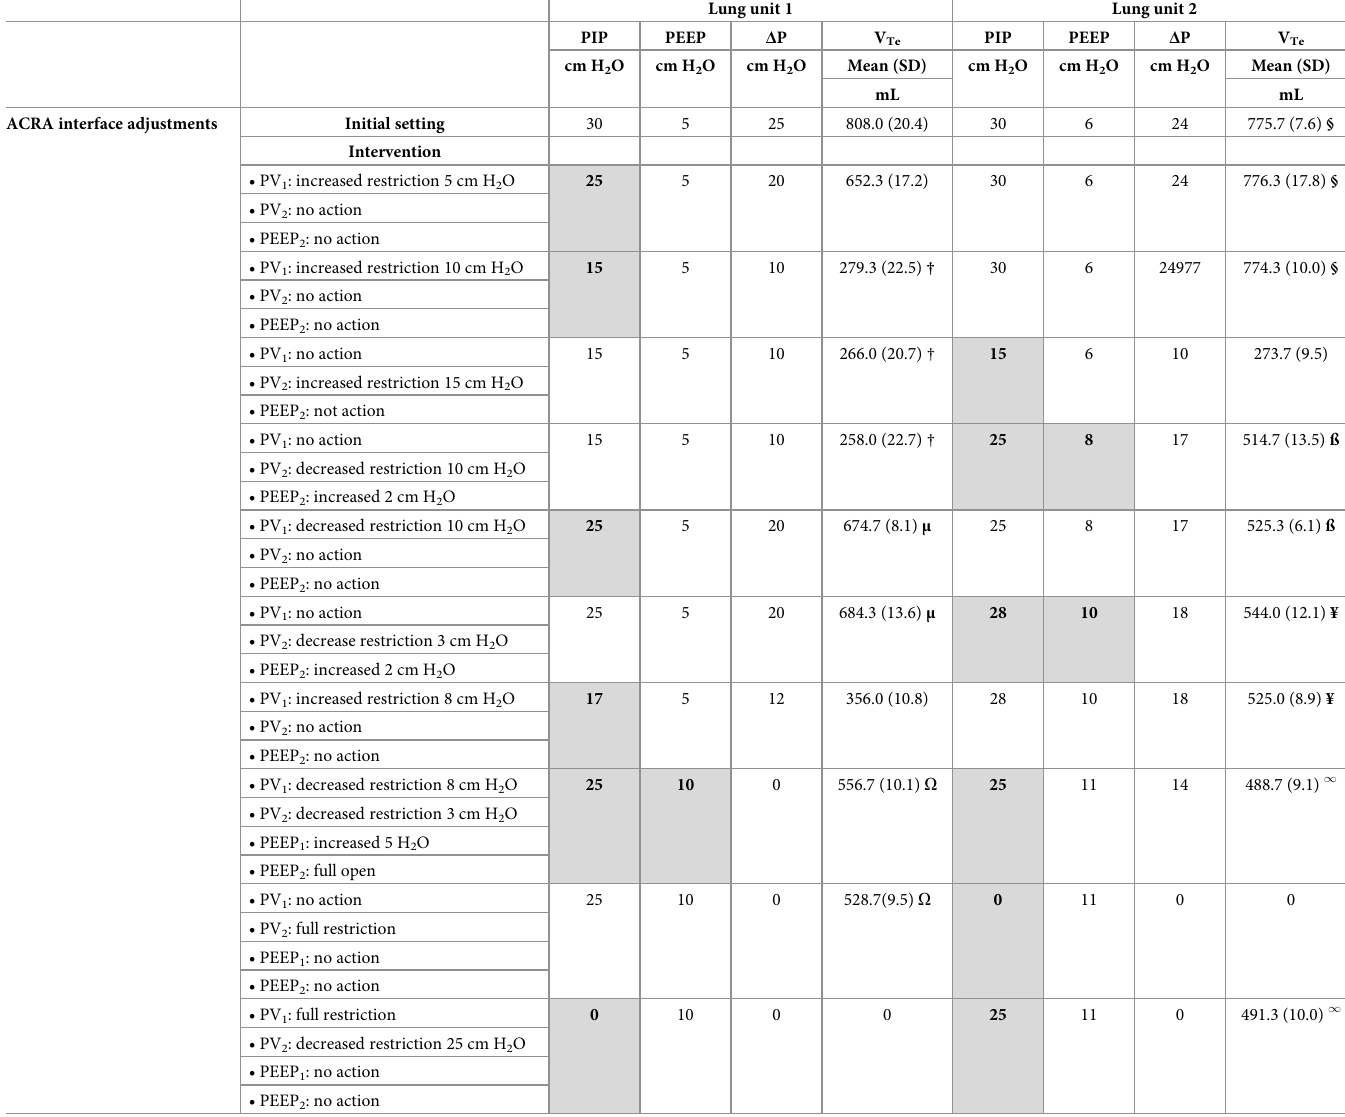
Table 2. Proposed variations of pressure on the pinch valves of both lung units (via adjustment of the flow restriction) and the positive end-expiratory pressure adjustable valve and the resulting values of peak inspiratory pressure, positive end-expiratory pressure, driving pressure and expired tidal volume on each lung